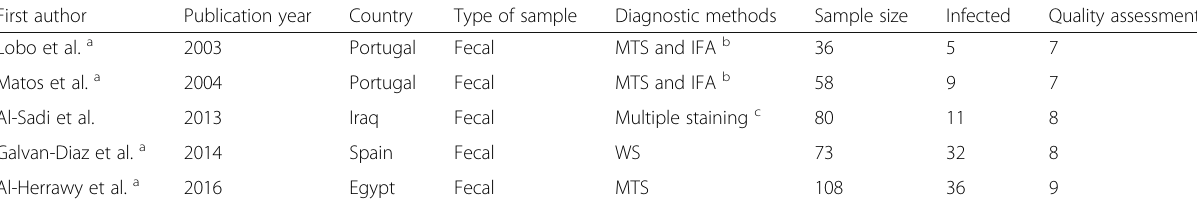
Table 4 All the studies investigating the global prevalence of microsporidia in dogs according to microscopy or coproantigens detection methods